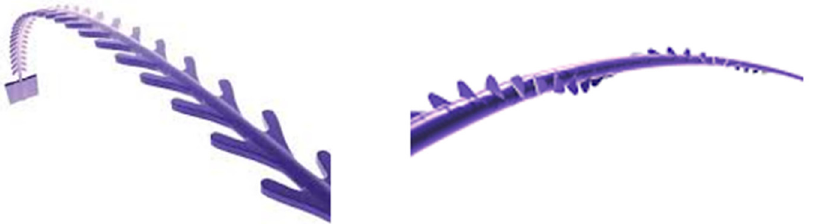
Figure 10. STRATAFIX TM PDS plus knotless tissue control and wound closure devices: Left: Sym- metrical barbs located on both sides of the suture. Right : A spiral array of barbs located around the metrical barbs located on both sides of the suture. Right: A spiral array of barbs located around the periphery [30]. periphery [30].